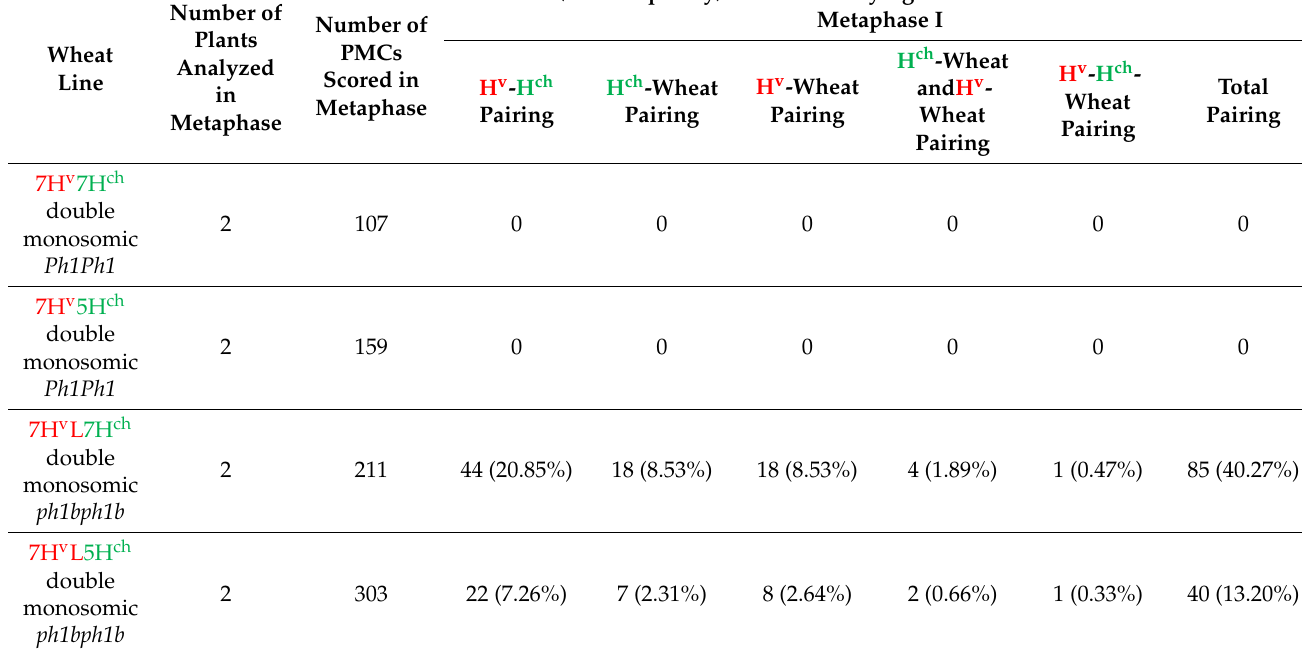
Table 2. Frequency of pairing between H. vulgare , H. chilense , and wheat chromosomes in metaphase I in double monosomic addition lines in the presence and in the absence of the Ph1